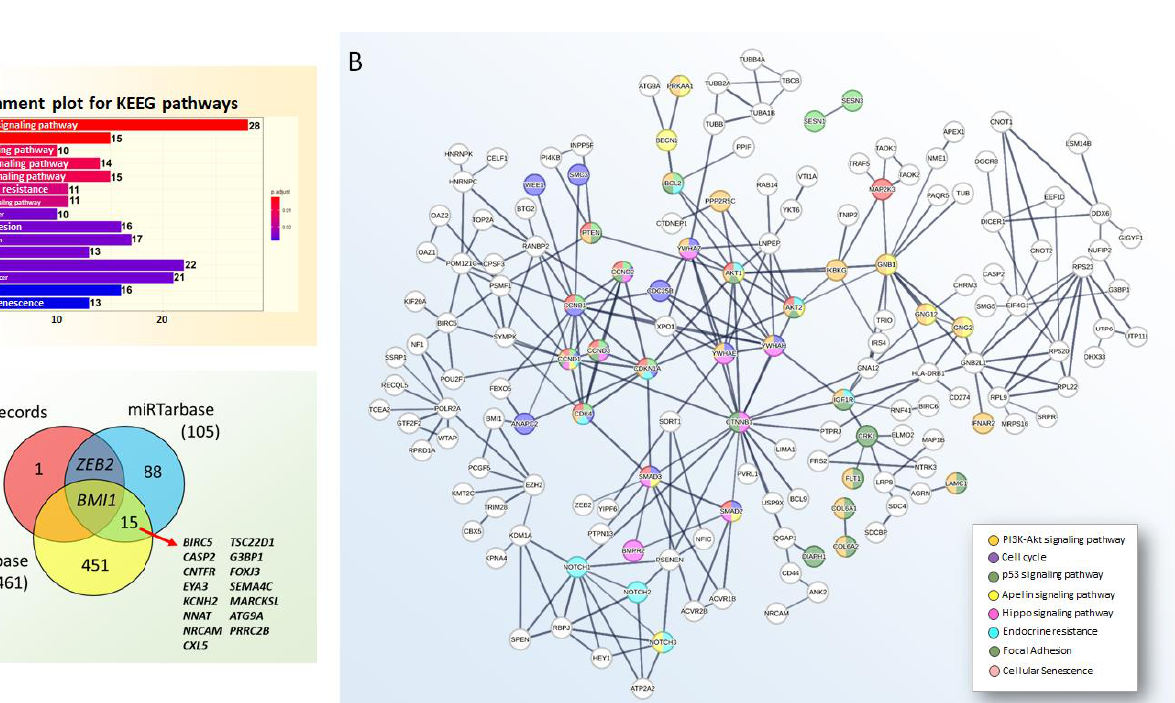
Table 1. Information about the role and main mechanism in cancer cells of miR-708 validated targets expression (shared at least between two databases). Target